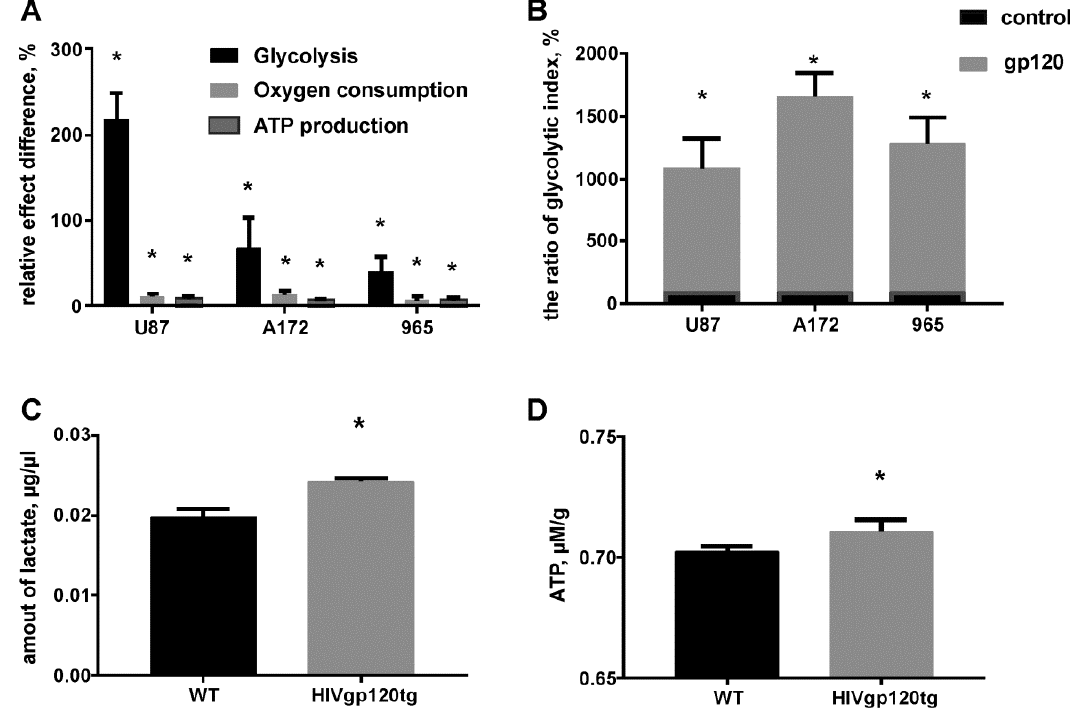
Figure 7. Gp120 causes a glycolytic shift in glioma cells. ( A ) Colorimetric/fluorometric assays were performed for multiplex detection of extracellular acidification, extracellular oxygen consumption and ATP production in U87, A172 and 965 glioma cells. ( B ) Quantification of intracellular rates of glycolytic index using extracellular acidification, oxygen consumption and glucose uptake measurements. Data presented as a percent deviation from the control. ( C , D ) Colorimetric assays were performed for detection of lactate ( C ) and ATP ( D ) in tumors generated in WT and HIVgp120tg mice by in-brain implantation of Gl261 cells. Mean ± S.E. and significant differences between control and gp120 treatment (*) are shown ( p < 0.05). Unpaired t -tests were used to determine the significance between groups. Five independent experiments ( n = 5) were used for statistical analysis.